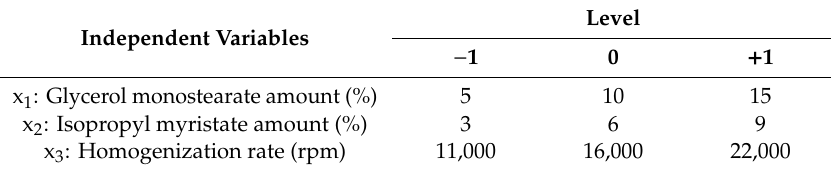
Table 1. Coded values of independent experimental variables.